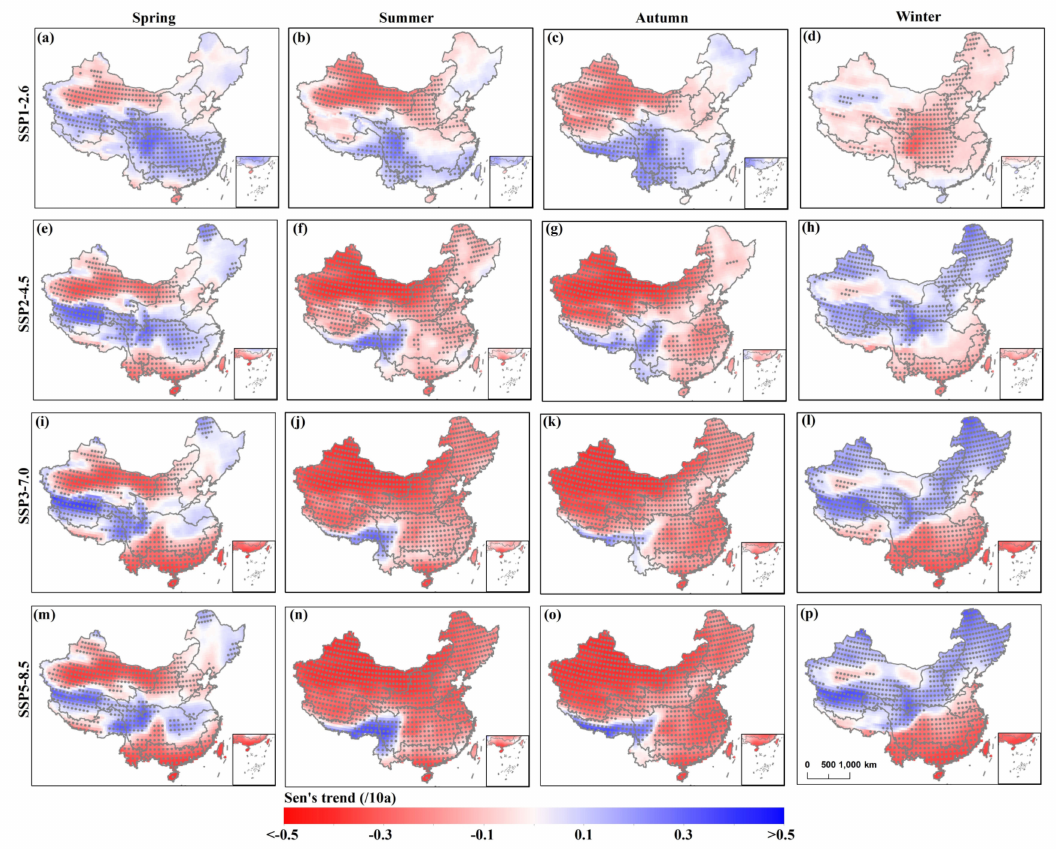
Figure 12. Spatial patterns of the SPEI03-based drought trend in ( a , e , i , m ) spring, ( b , f , g , n ) sum- mer, ( c , g , k , o ) autumn, and ( d , h , l , p ) winter across China under the ( a – c ) SSP1-2.6, ( d – f ) SSP2-4.5, ( g – i ) SSP3-7.0, and ( j – l ) SSP5-8.5 scenarios for the future period (2015–2099). The SPEI03-based drought trend was calculated using Equation (7) across China. Gray dots indicate significance at a 99% confidence level using the Mann–Kendall method. Among them, the division of seasons is consistent with Figure